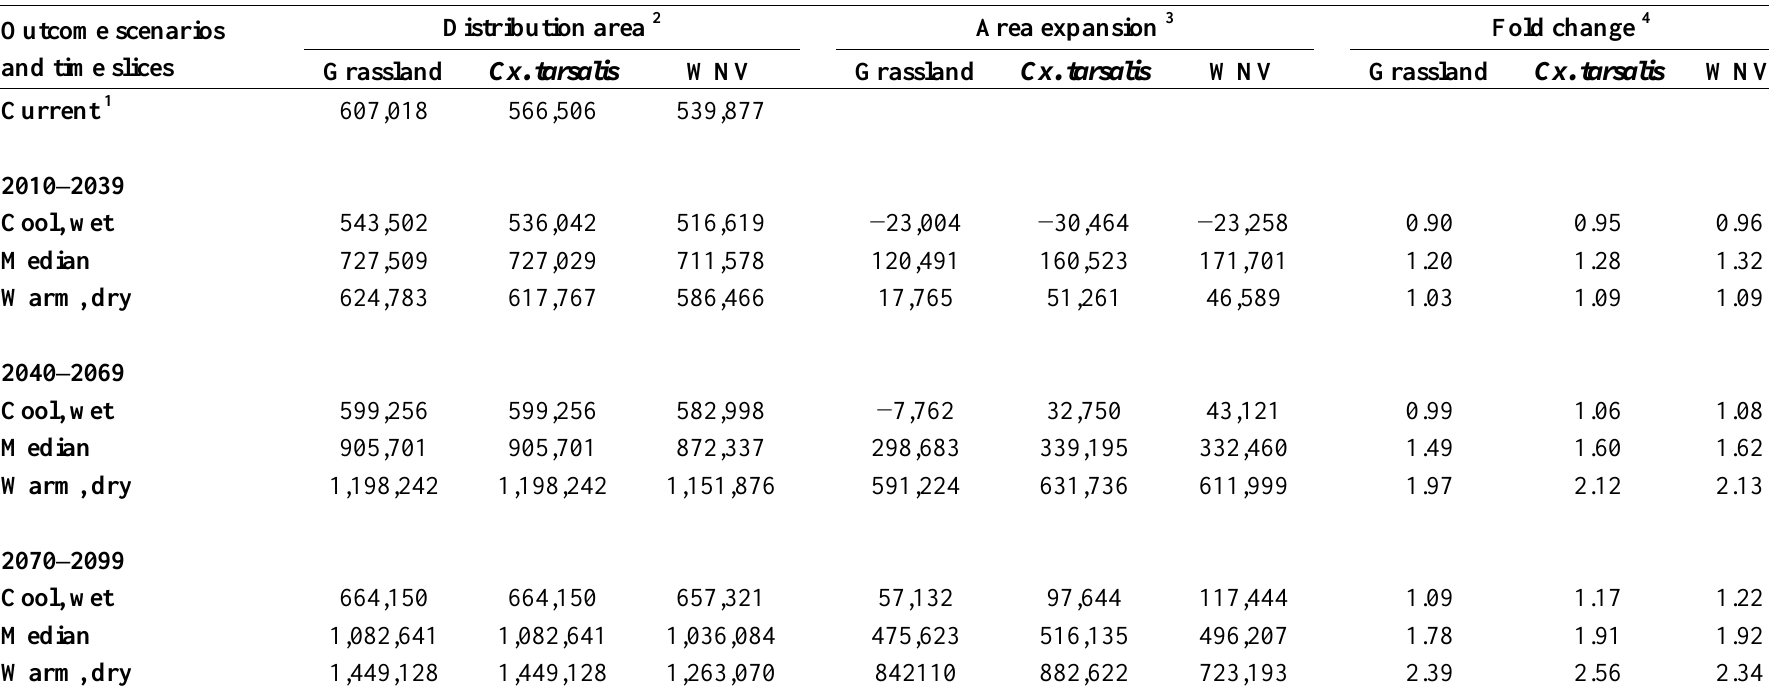
Table 4. Predicted distribution and range expansion of grassland habitat, the mosquito vector Cx. tarsalis , and WNV in the prairie provinces under current and future climate conditions. The predicted distribution of Cx. tarsalis and WNV was assumed to be limited by the availability of grassland